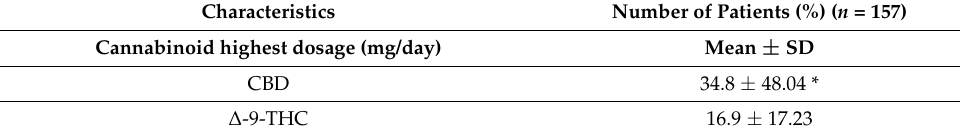
Characteristics